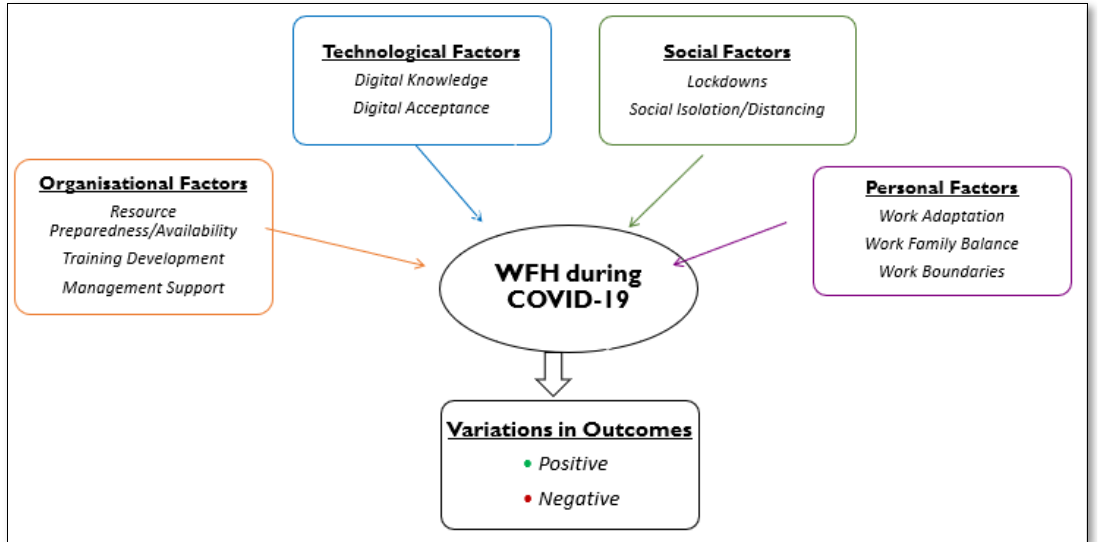
Figure 1. A quadrant factorial analytical framework of WFH. (Configured by the authors).